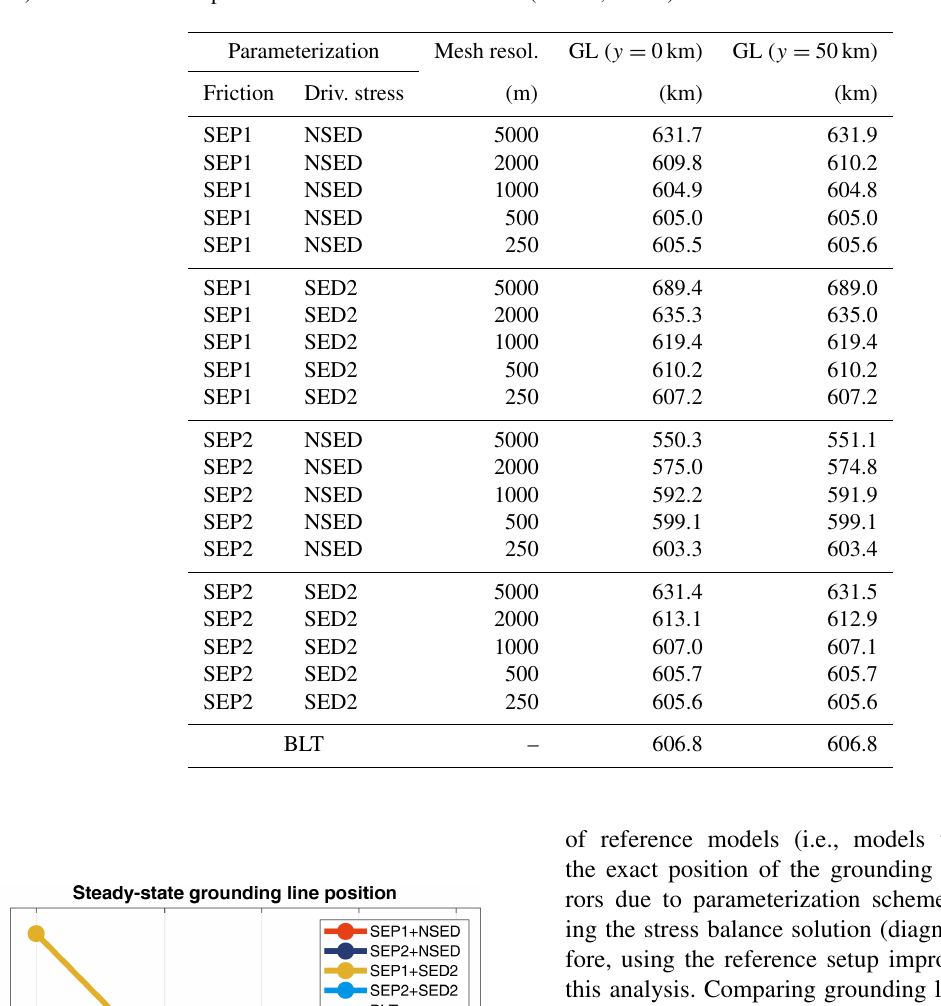
Table 4. Steady-state GL positions for the MISMIP3d setup using different sub-element parameterization schemes. GL positions for SEP1 + NSED and SEP2 + NSED are extracted from Seroussi et al. (2014a). We employ the same numerical setup as described in Seroussi et al. (2014a). The estimated GL position from BLT is also included (Schoof, 2007b).